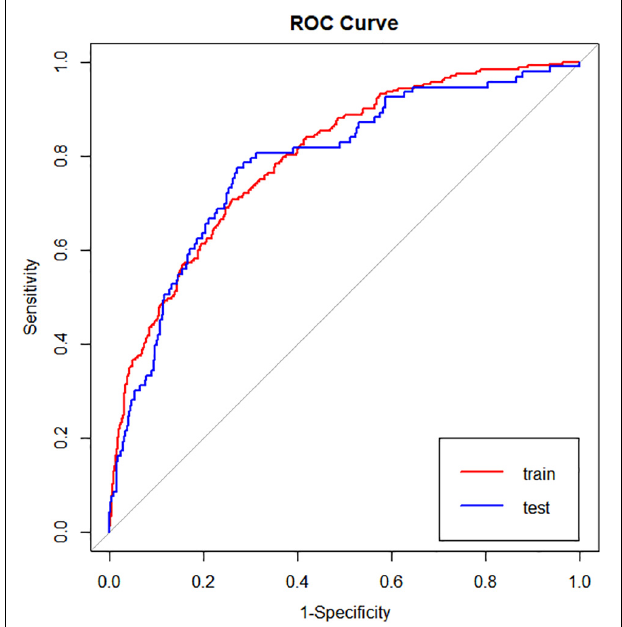
Frontiers in Physiology |